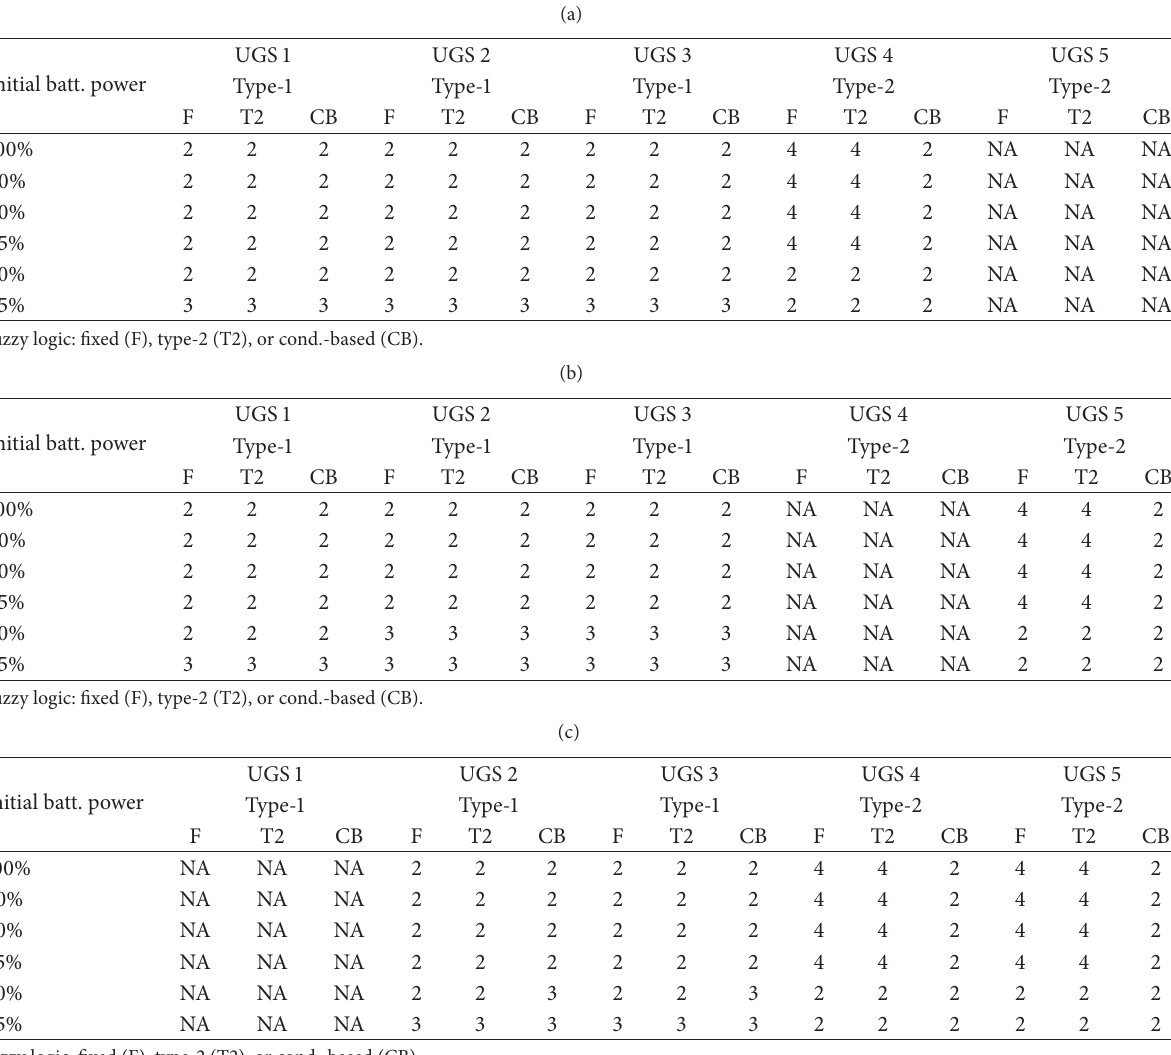
Table 4: (a) Selection of wake-up sensor at UGS for fixed, type-2, and condition-based fuzzy logic: target 1. (b) Selection of wake-up sensor at UGS for fixed, type-2, and condition-based fuzzy logic: target 4. (c) Selection of wake-up sensor at UGS for fixed, type-2, and condition-based fuzzy logic: target 6.